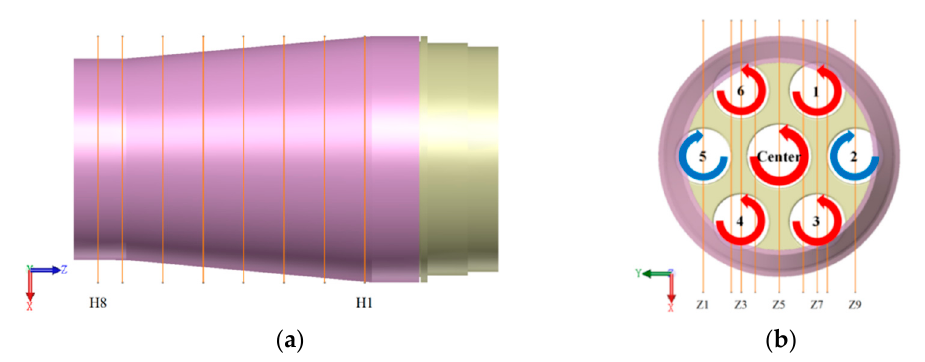
Figure 4. Section positions. ( a ) Cross sections; ( b ) longitudinal sections.